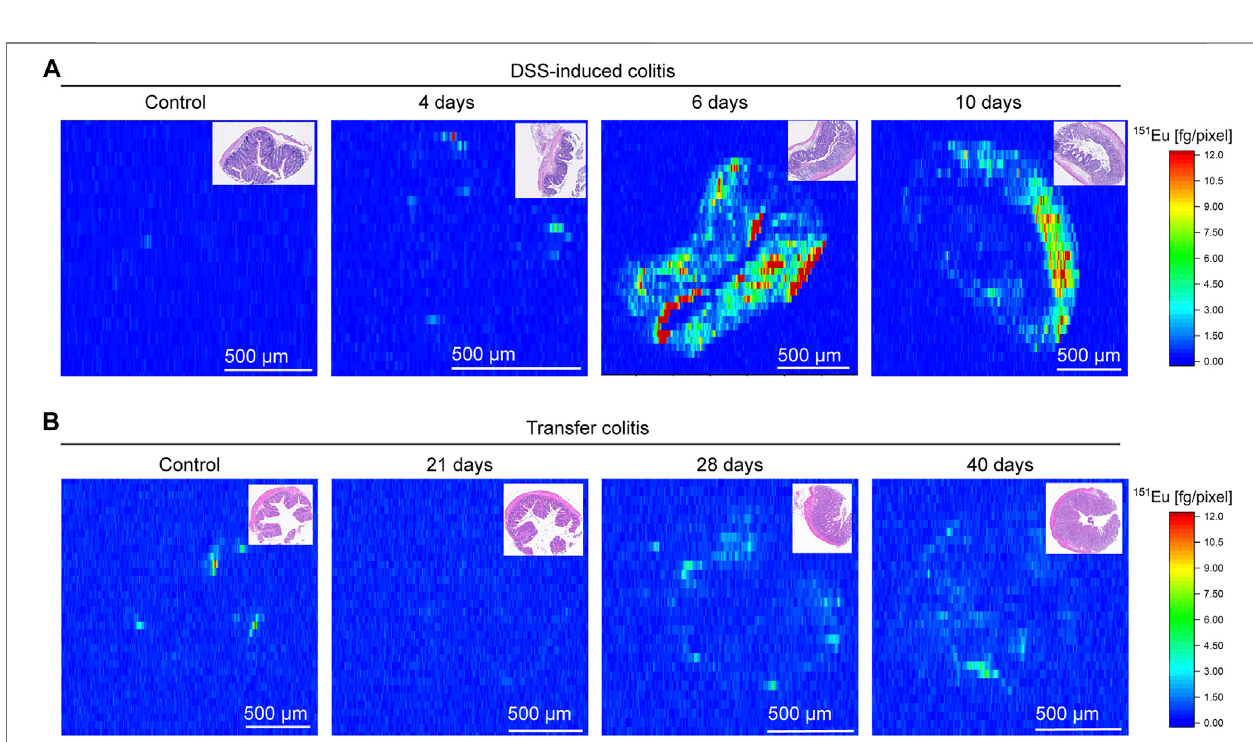
FIGURE 6 | Europium (Eu) content measured with laser ablation inductively coupled mass spectrometry (LA-ICP-MS) is higher in colon tissue of DSS-induced colitis as in transfer colitis. Representative elemental maps of Eu in DSS-induced colitis (A) at day 4, 6, and 10 with respective control and respective H&E staining of measuredsampleintheupper rightcorner.ThescalebarreferstotheamountofEuinrespectivepixelinfg/pixel.Intransfercolitis (B) therepresentativeelementalmaps for different time points (day 21, 28 and 40) and healthy control generated with LA-ICP-MS underline lower abundance of Eu and therefore VSOPs. The H&E staining of measured tissue is shown in the upper right